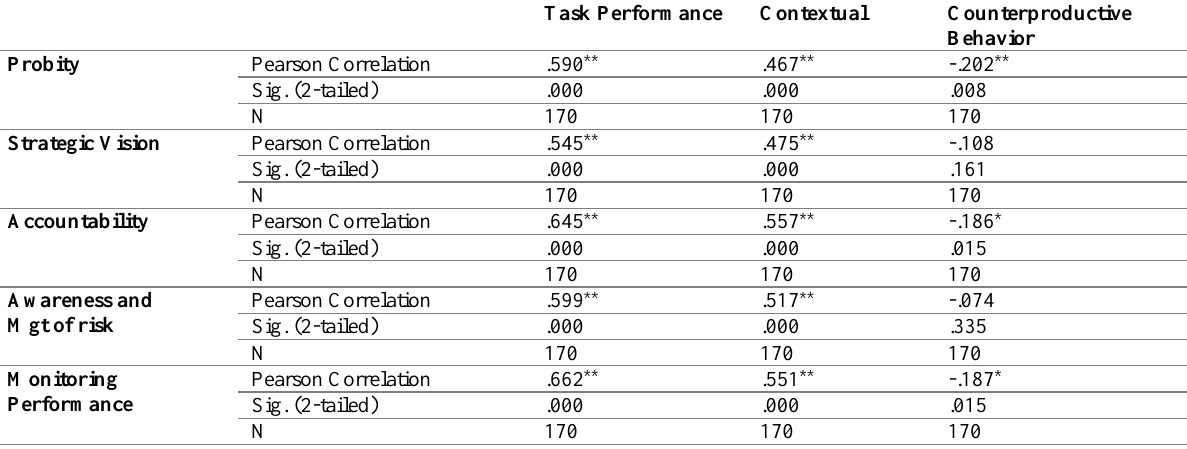
Table 11: Relationship between Corporate Governance and Individual Work